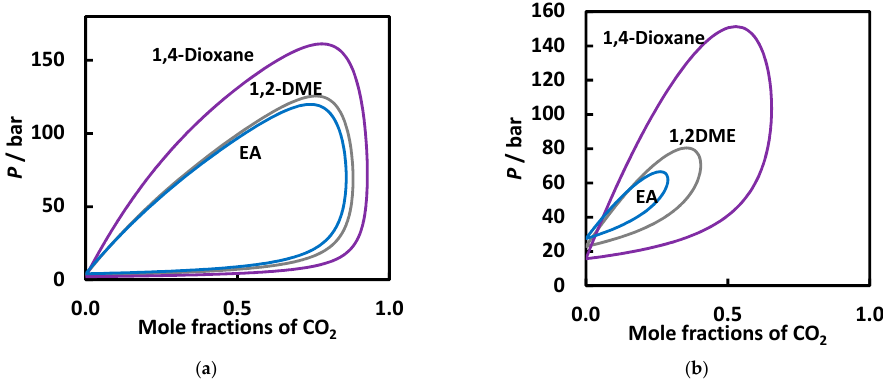
Figure 10. VLE behavior at 400 K ( a ) and 500 K ( b ) for the carbon dioxide + ethyl acetate, carbon dioxide + 1,4-dioxane, and carbon dioxide + 1,2-dimethoxyethane binary systems. The lines correspond to PR EoS predictions with the BIPs k 12 = 0.025 and l 12 = − 0.108.